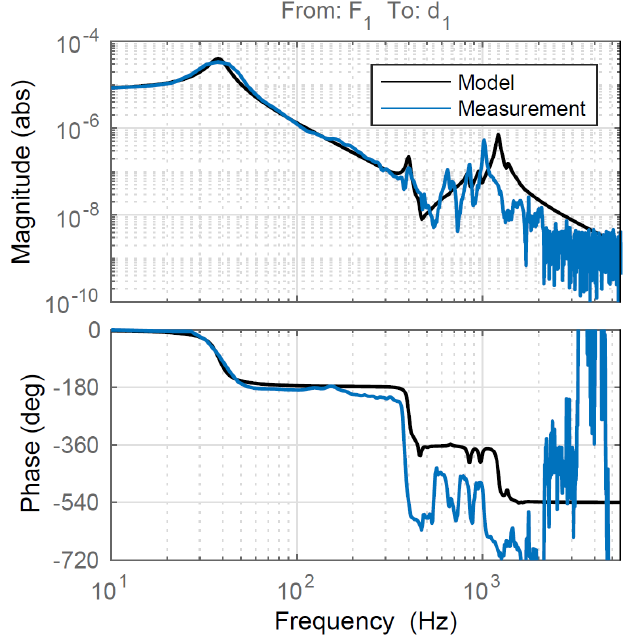
Figure 7. The simulated and measured frequency response function of the Flowerbed with the reluctance actuator [14].